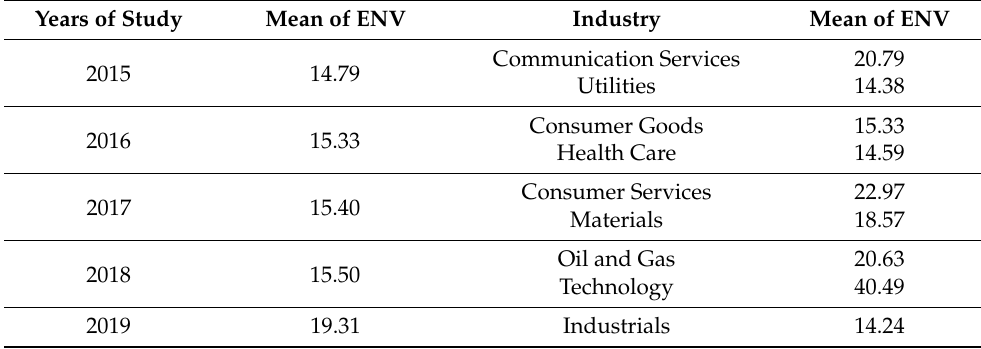
Table 1. Descriptive statistics for environmental disclosure within each industry and years of